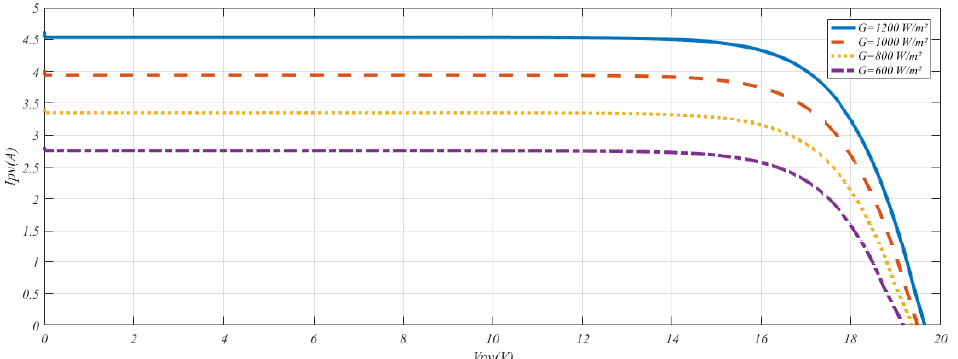
Figure 4. Ipv = f(Vpv) of the PV Generator.